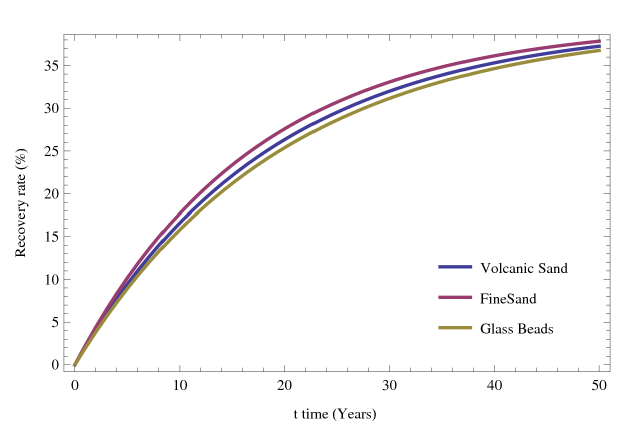
Fig. 7: Recovery rate in fractured porous medium under effect of magnetic field